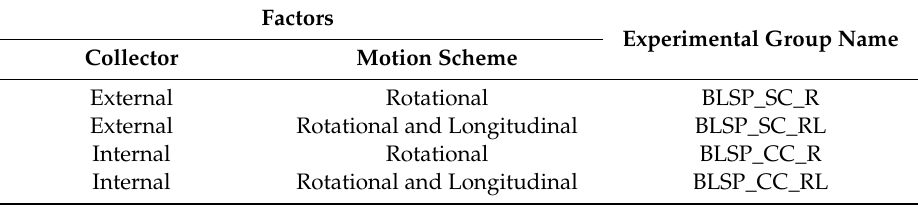
Table 2. Characteristics used for the electrospinning